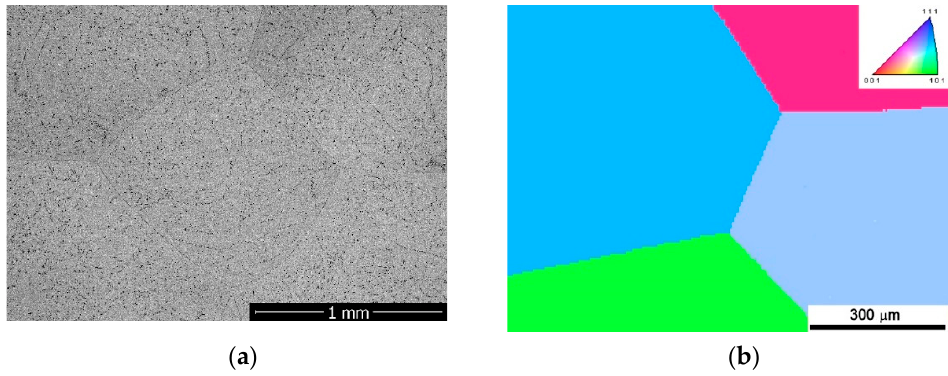
Figure 4. ( a ) Etched microstructure and ( b ) inverse pole figure map of grains of a HIP’d NbTiZr